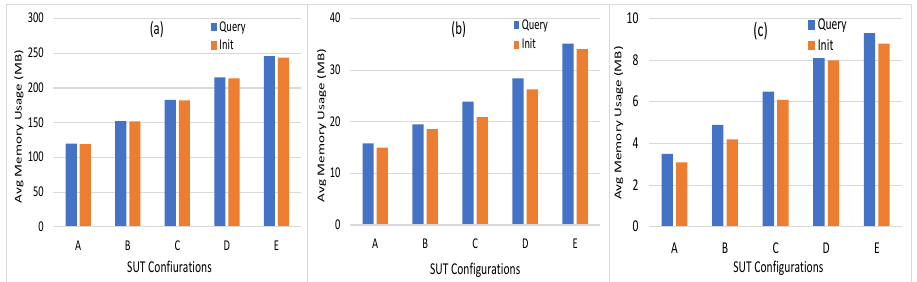
Figure 6. Average memory usage of ( a ) peer nodes, ( b ) orderer node, ( c ) chaincode.